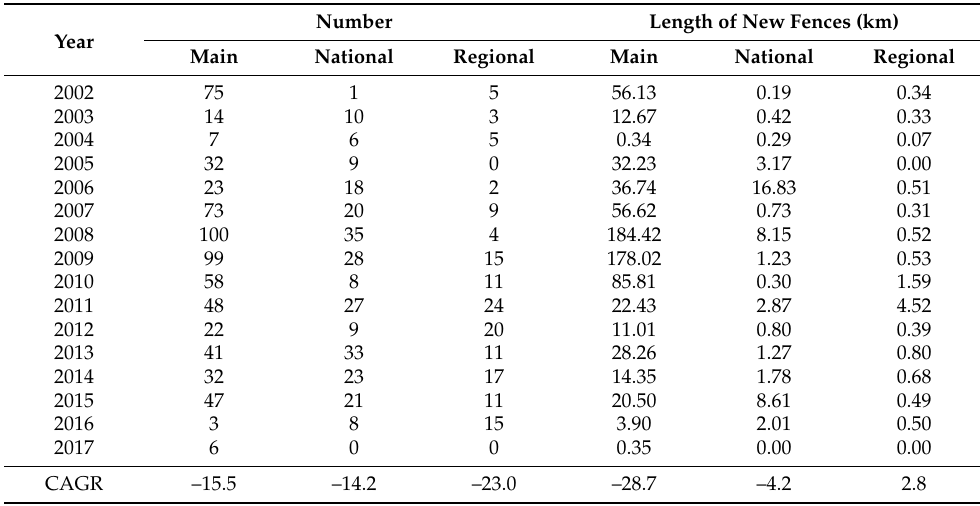
Table A4. The number and length of new fences built on different categories of